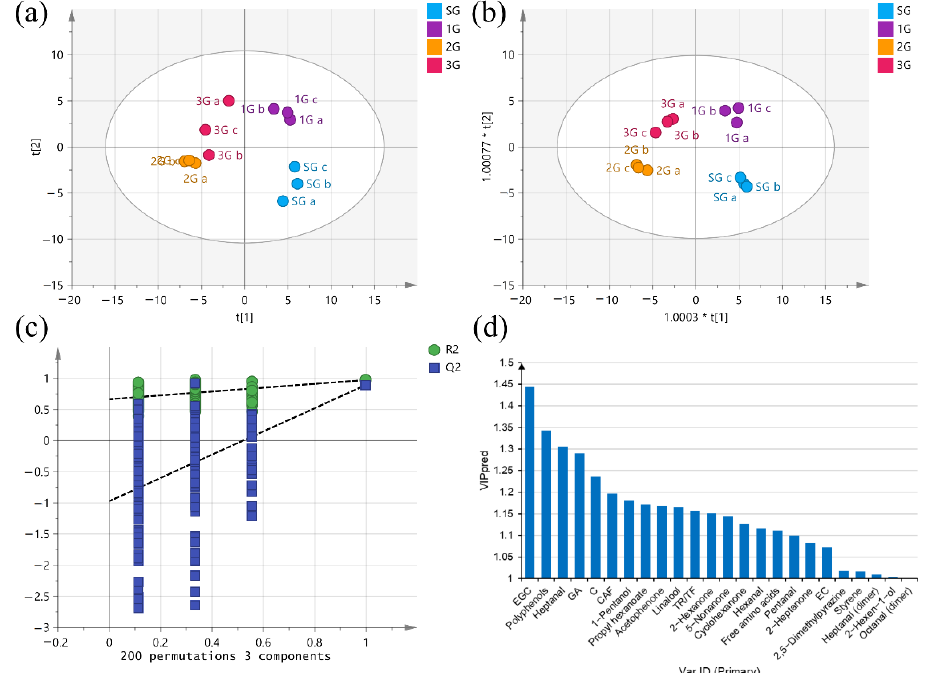
Figure 6. The PCA score plot and OPLS-DA score plot of PCT. ( a ) PCA score chart, R 2 X [1] = 0.495, R 2 X [2] = 0.208, Q 2 = 0.566; ( b ) OPLS-DA score chart, R 2 X [1] = 0.491, R 2 X [2] = 0.189, Q 2 = 0.781. ( c ) Cross-validation plot of the OPLS-DA model, R 2 = 0.664, Q 2 = – 0.971. ( d ) VIP plot of markers with VIP > 1.